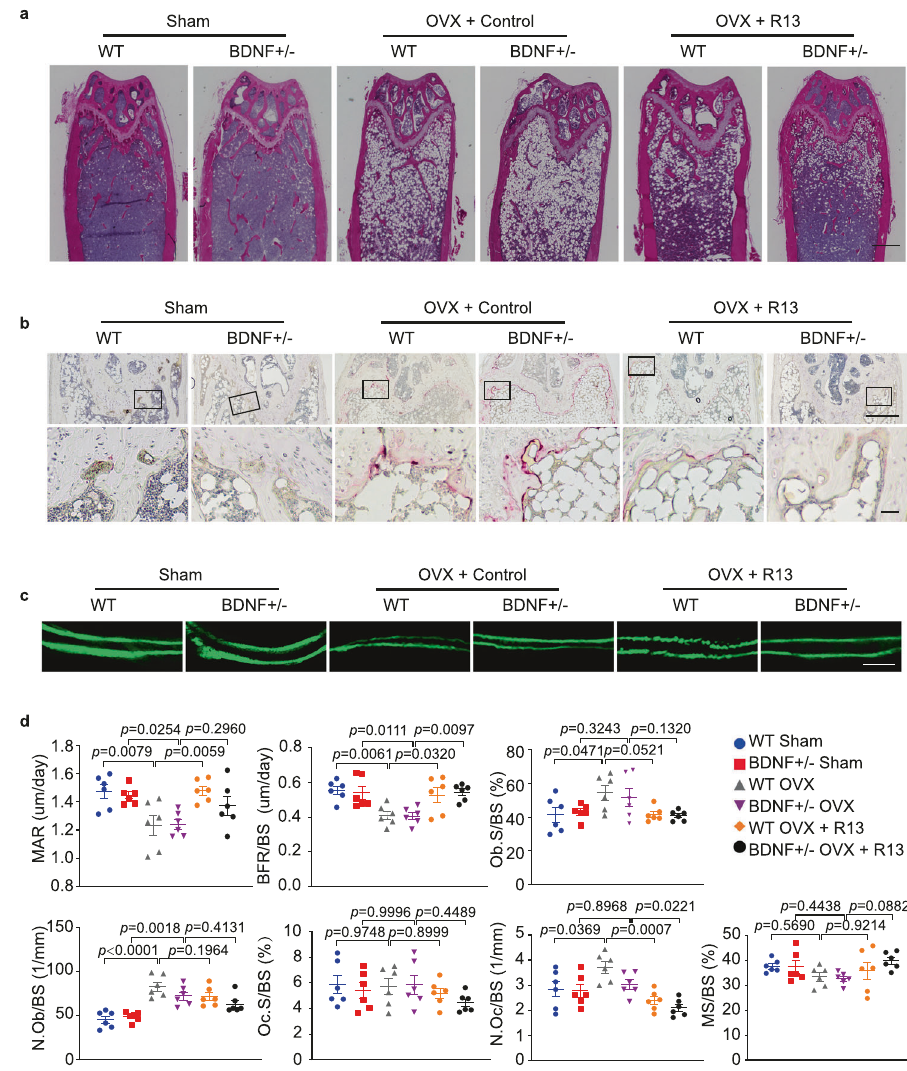
c Mice were injected subcutaneously with calcein at day 10 and day 3 before sacri fi ce. Representative images of calcein double- fl uorescence labeling images (green) of the trabecular bone in WT sham, BDNF+/ − sham, WT OVX, BDNF+/ − OVX, and WT OVX+R13, BDNF+/ − OVX+R13 group ( n =6 mice per group) (Scale bar, 30 μ m). d Histomorphometric indices of bone turnover in WT and BDNF+/ − mice afterOVX with or without R13 treatment. N.Oc/BS and Oc.S/BSare indices of bone resorption. N.Ob/BS, Ob.S/BS, MAR, BFR/BS and MS/BS are indices of